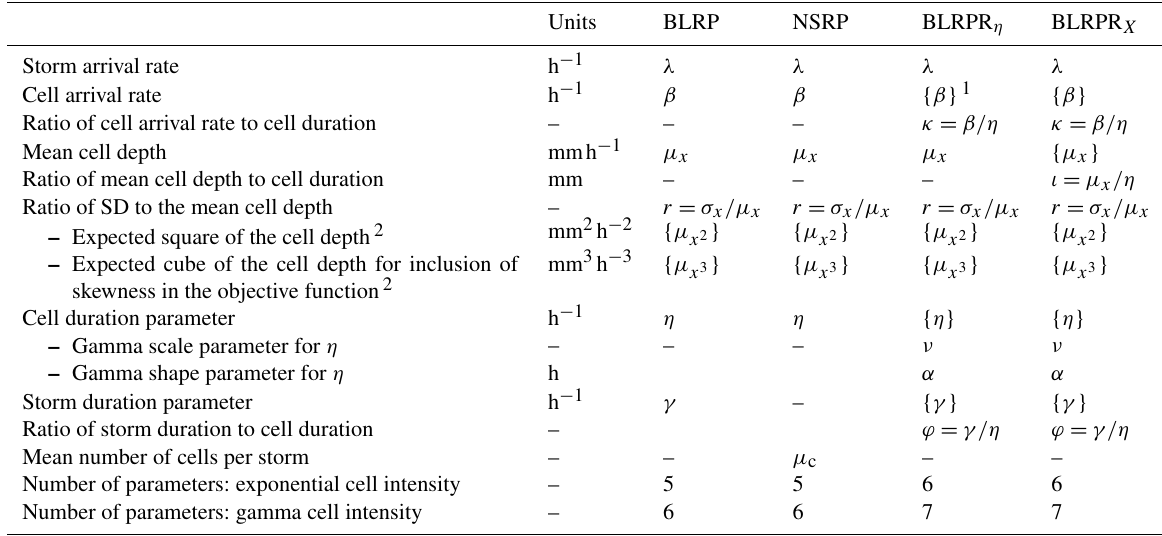
Figure 2. Rainfall generation mechanism for mechanistic stochastic models with rectangular pulses. Panel (a) shows the arrival of storms and cells. Rain-cell intensity defines the height of each cell ( X ), and duration the length ( L ). Panel (b) shows the unobserved continuous-time rainfall time series derived from the superposition of cells shown in (a) . Table 1. Model parameters for the original and two randomized Bartlett–Lewis rectangular pulse models (BLRP, BLRPR η , and BLRPR X ) and the original Neyman–Scott rectangular pulse model